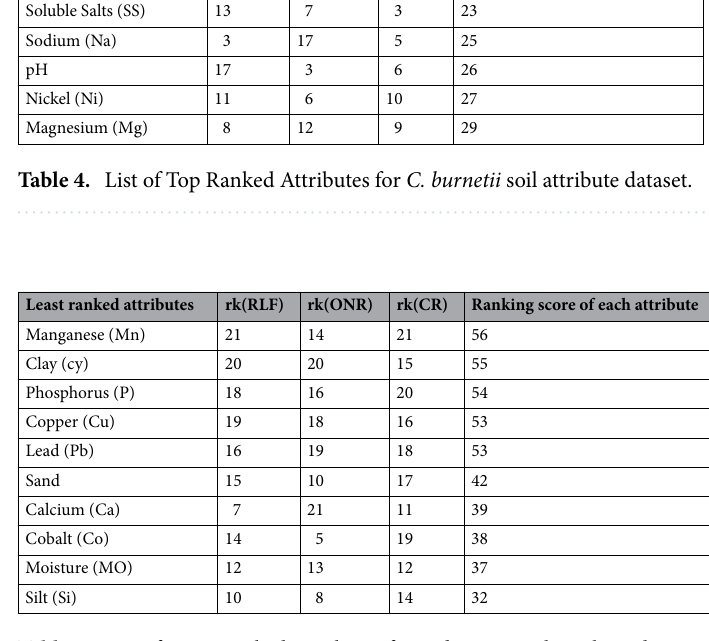
Table 5. List of Least Ranked Attributes for C. burnetii soil attribute